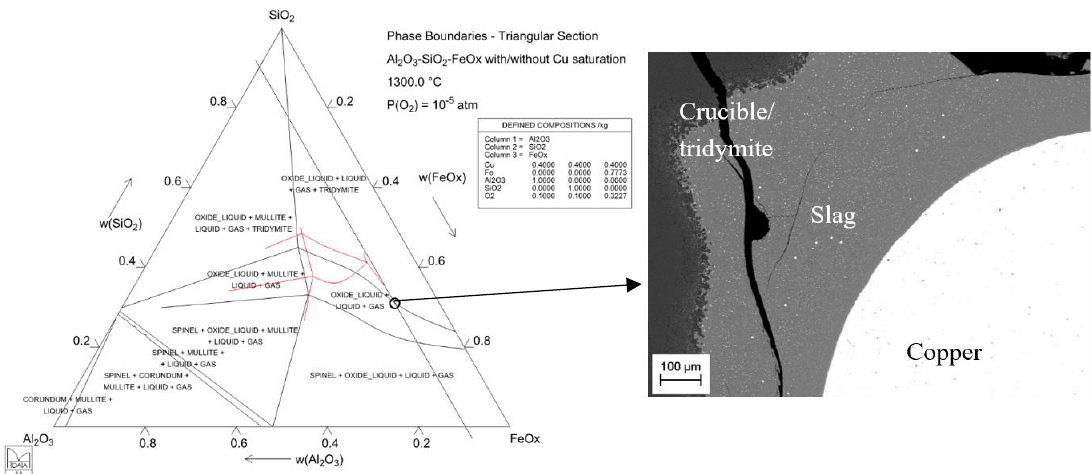
Figure 1. One of the slag target points in this study shown in Al 2 O 3 -SiO 2 -FeO x phase diagram and in the corresponding sample micrograph. The phase diagram is calculated employing the MTDATA and MTOX database [28].